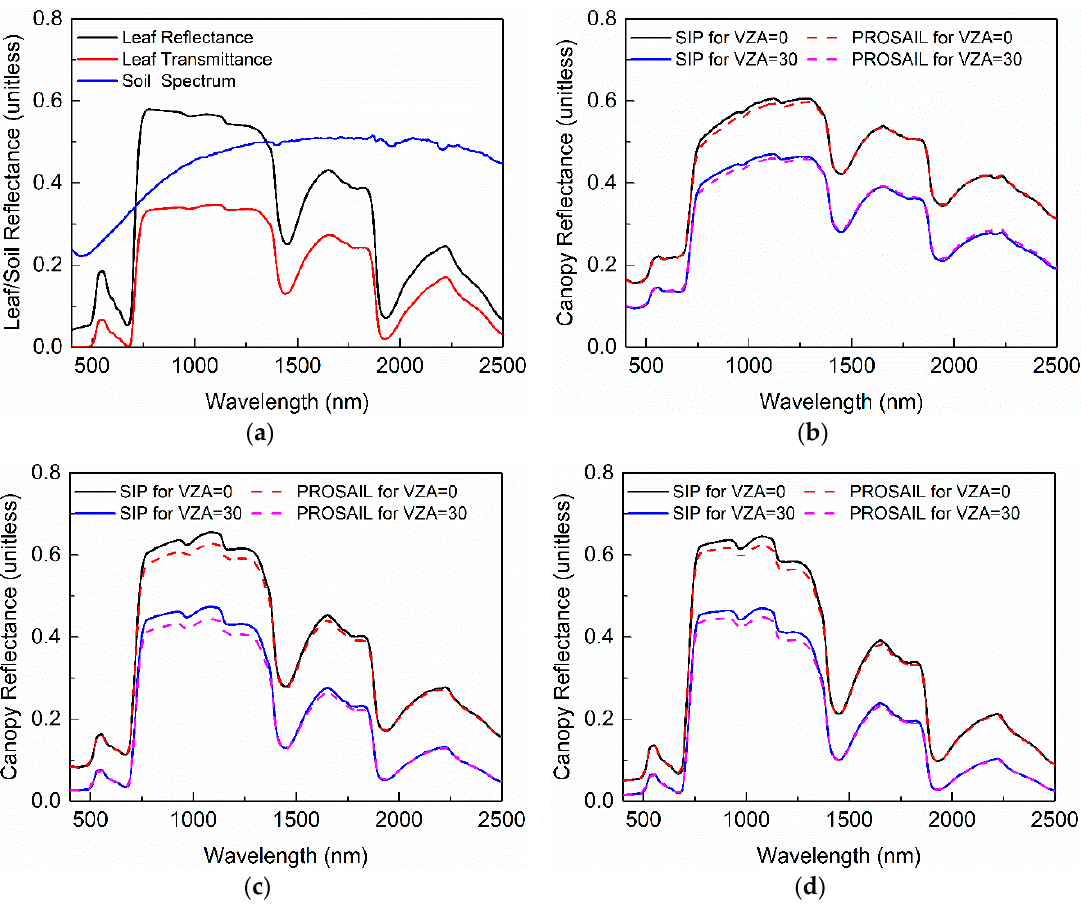
Figure 4. The input leaf/soil spectrum ( a ) and canopy-scale spectrum simulations by SIP and PROSAIL ( b – d ). VZA represents the view zenith angle. The leaf area index (LAI) is 1 ( b ), 3 ( c ) or 5 ( d ), respectively, LAD is erectophile, and the solar zenith angle is 0°. The other input parameters are the same as Table 1.